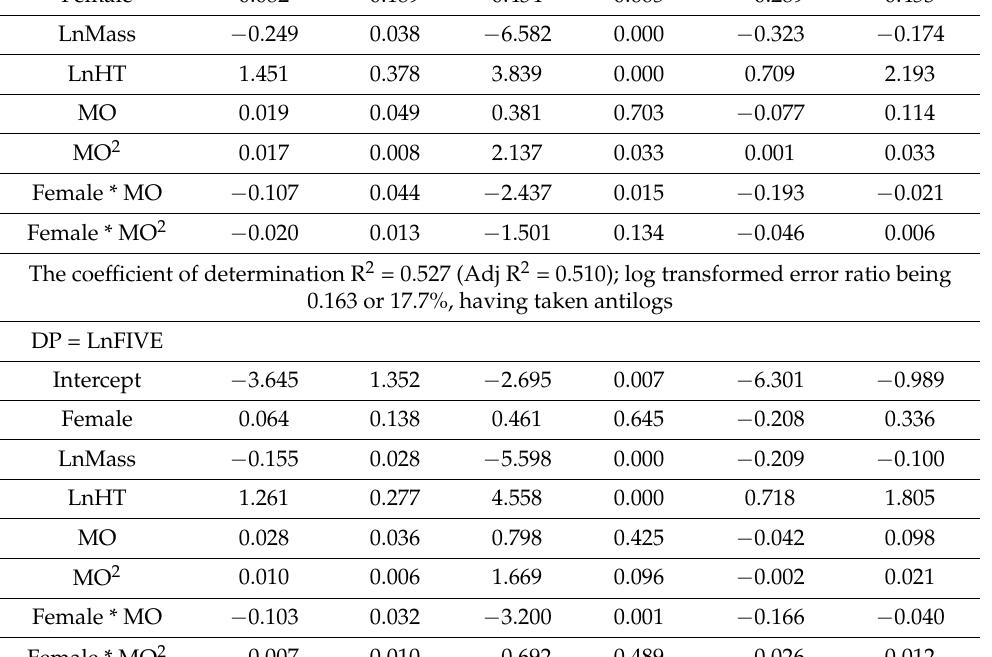
Table 3. The fitted ANCOVA parameters predicting log-transformed standing long jump Ln (SLJ) and the five jump test Ln (FIVE) using the covariates described in Equation (2). DP = LnSLJ B